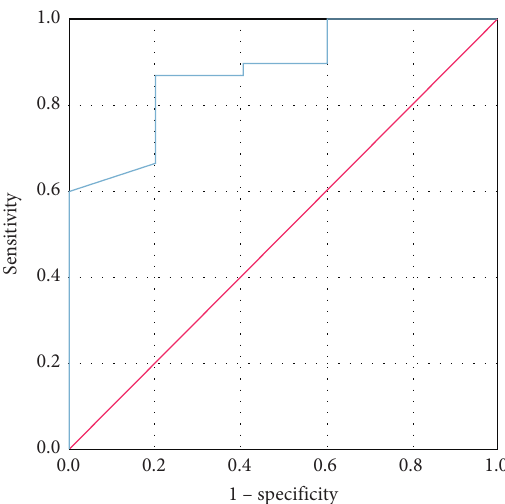
Figure 2: ROC curve analysis. ROC curve analysis for the association between mean CWP and an infarcted area ≥ 24% of left ventricular mass (AUC � 0.880, p � 0 . 007). A CWP value ≤ 24.5mmHg was found as the optimal cutoff value to predict an infarct size ≥ 24% of left ventricular mass. AUC � area under the curve; CWP � coronary wedge pressure; and ROC � receiver operating characteristic.